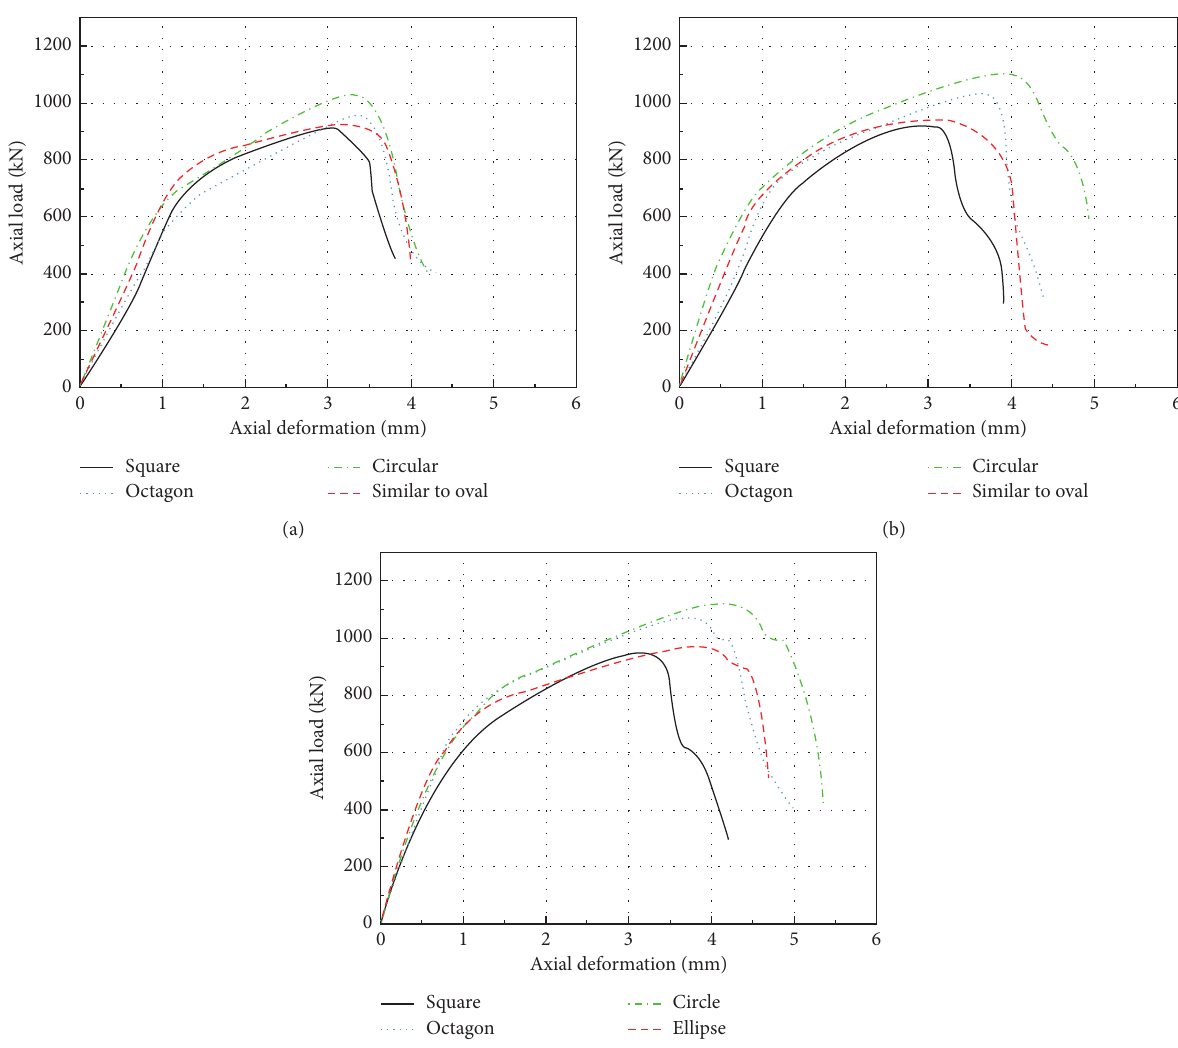
Figure 6: Load versus deformation relationship of specimens. (a) CFRP reinforcement. (b) One-layer CC and CFRP reinforcement. (c) Two-layer CC and CFRP